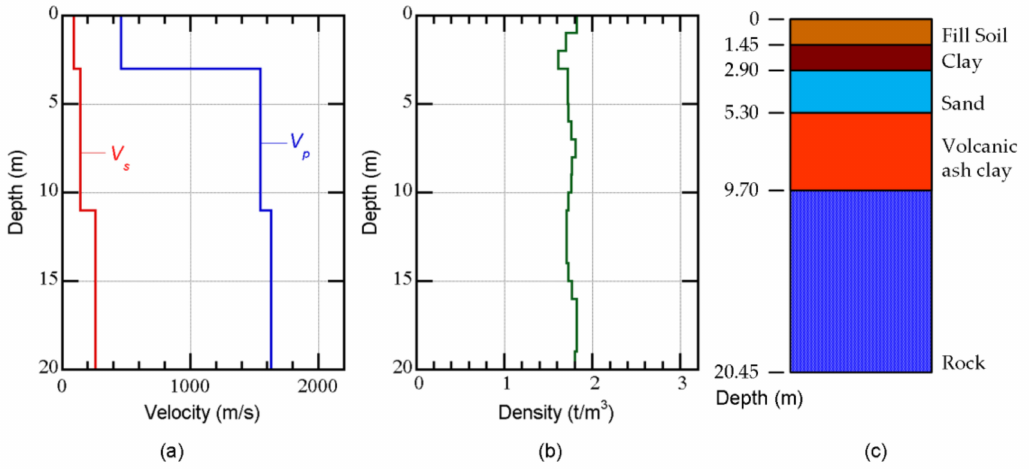
Figure 6. Soil profiles of the former K-NET Uto station. Figures were made from the data provided by the National Research Institute for Earth Science and Disaster Resilience (NIED). ( a ) Primary and shear wave profile ( V p : P-wave velocity, V s : S-wave velocity); ( b ) density profile; ( c ) soil